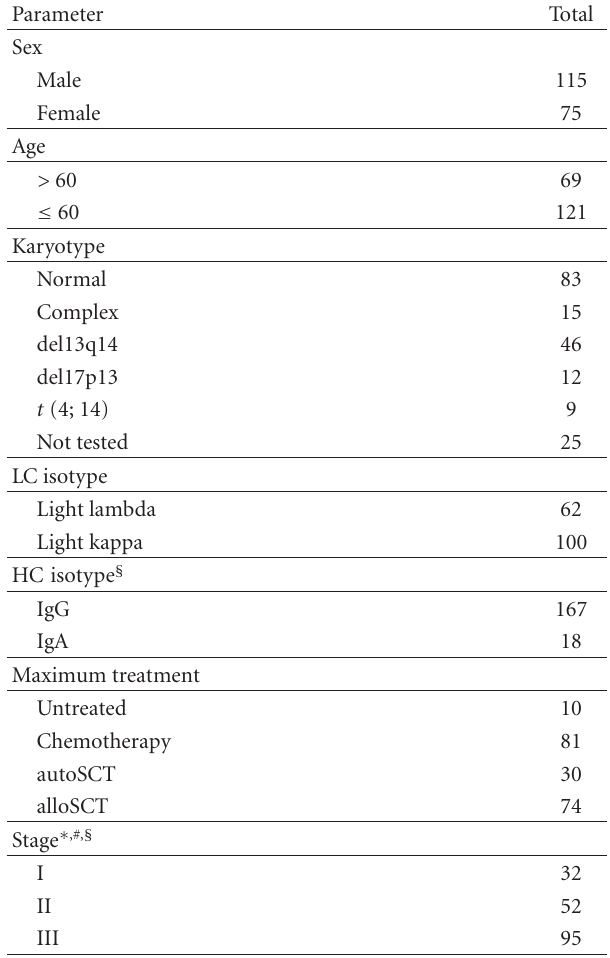
Table 1: Patient characteristics. Data are shown for all patients. LC: light chain, HC: heavy chain. § indicates missing information for some